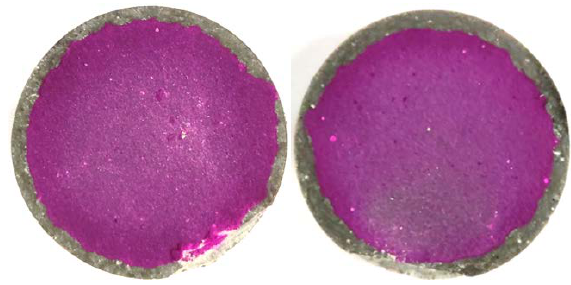
Figure 8. The cement paste after being corroded for 30 days. Table 4. Corrosion depth of cement